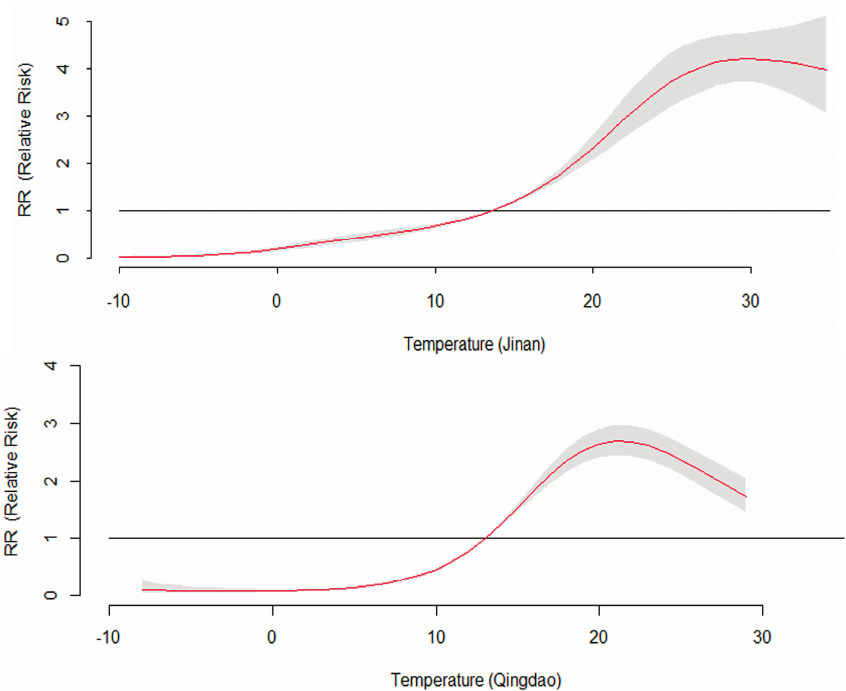
Figure 6. Effect of daily mean temperature on daily HFMD incidence over lags from 0 to 14 days in the study cities, controlling for relative humidity, rainfall, sunshine duration, DOW, holidays, seasonal trend, and long trend. The maximum likelihood estimate of RRs is shown as smooth red lines and the pointwise 95% confidence intervals are shown in the gray